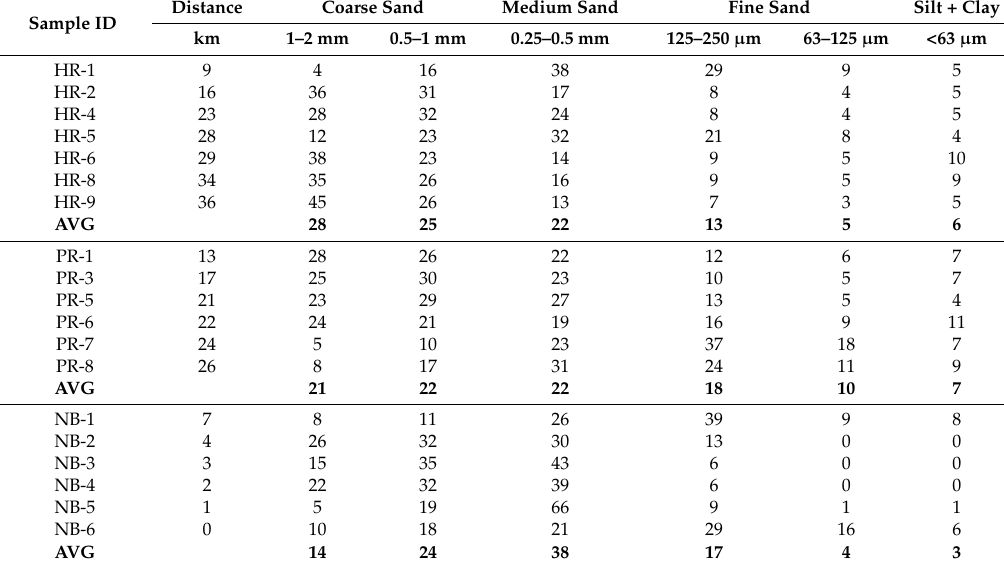
Table 5. Grain size distribution (wt %) for sediments (<2 mm grain size) collected from the Hackensack River (HR), the Passaic River (PR), and the Newark Bay (NB) in summer 2016. Distance (km) indicates the distance from NB-6 located near the mouth of the Newark